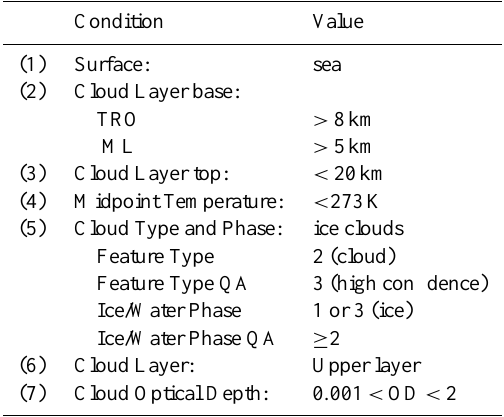
Table 1. Conditions used for the selection of clouds in the Reduced Database.